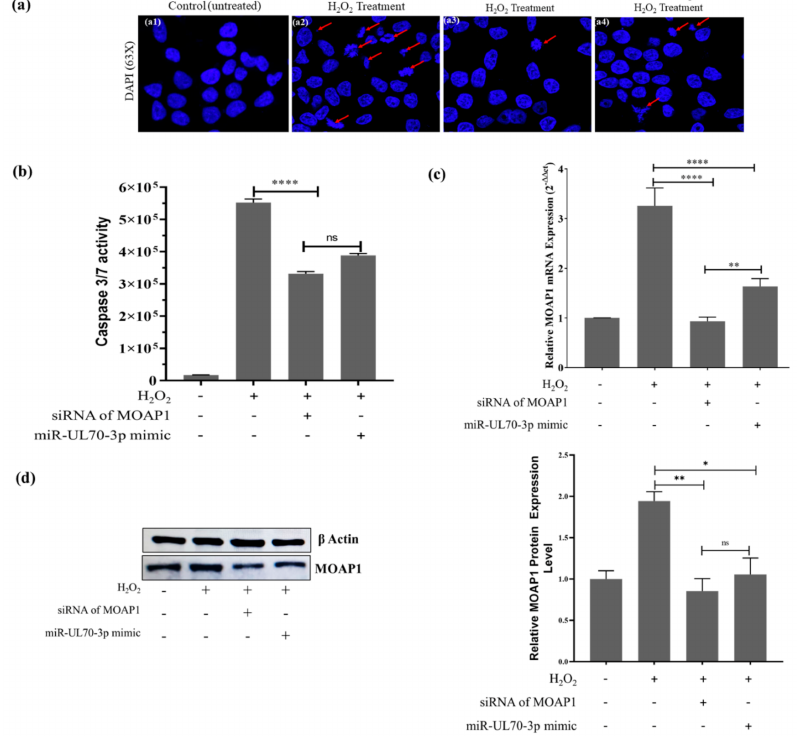
Figure 3. Comparison of downregulation of apoptosis/MOAP1 by siRNA of MOAP1 and hcmv- miR-UL70-3p: ( a ) Through DAPI imaging, images (63 × ) showing the nuclear morphology. ( b ) Mea- surement of Caspase 3/7 activity: The Caspase 3/7 activities were measured through Caspase Glo 3/7 assay in four different groups of cells, as mentioned above, these were recorded as raw lumi- nescence units (RLU) ( ± SEM; **** p < 0.0001). ( c ) MOAP1 mRNA downregulation: The relative expression levels of MOAP1 mRNA after the transfection of either hcmv-miR-UL70-3p and siRNA of MOAP1 were measured through qRT-PCR. Results were expressed as the fold change (2 − ∆∆ Ct ) ( ± SEM; **, p < 0.01; ****, p < 0.0001). ( d ) MOAP1 protein downregulation: The MOAP1 protein down- regulation after transfection with either siRNA of MOAP1 and hcmv-miR-UL70-3p were analyzed through Western blot. The relative MOAP1 protein quantification was performed through ImageJ software after normalizing with β -actin. Experiments were performed in triplicates (Supplementary Figure S2b), and the data from three different experiments were used for statistical analysis ( ± SEM; *, p < 0.05; **, p < 0.01, ns =